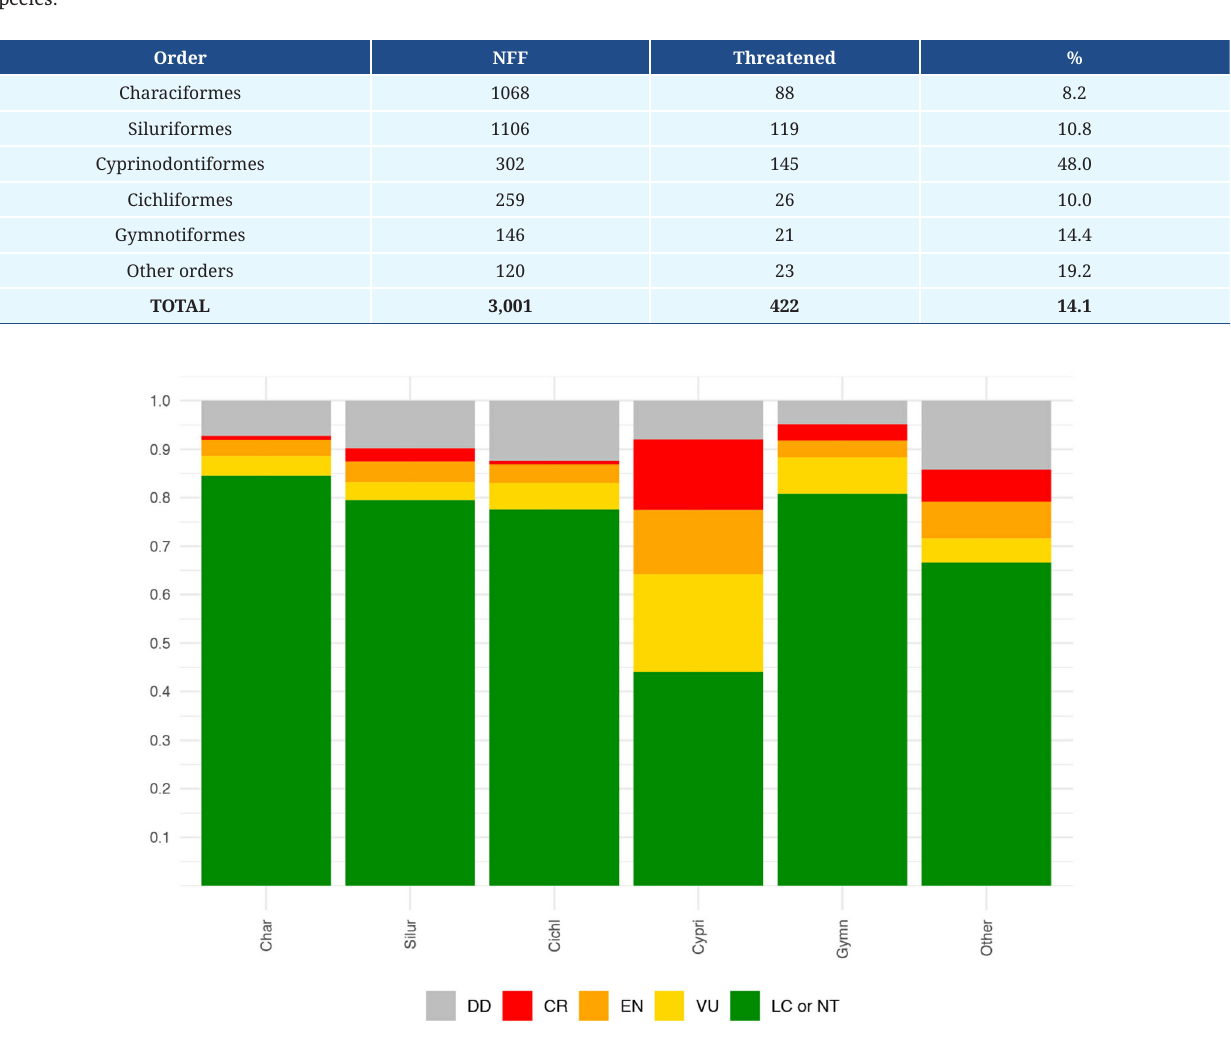
TABLE 1 | Summary of the IUCN–RL data for 3,001 Neotropical freshwater fish (NFF) species. Threatened = number of threatened NFF